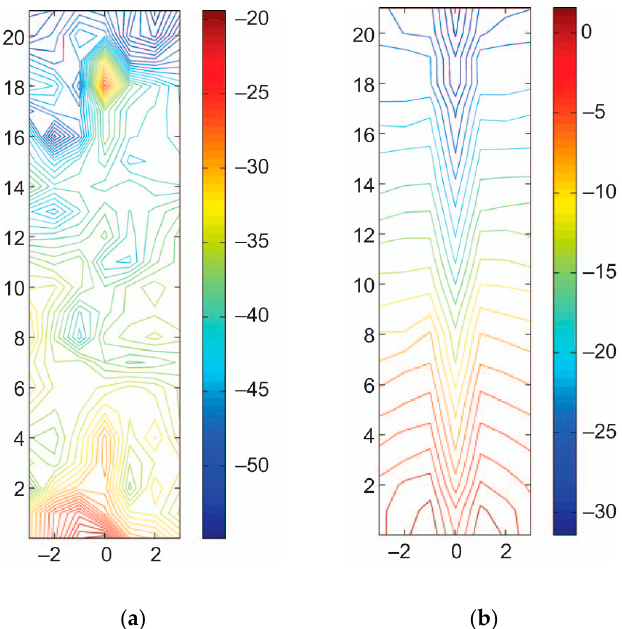
Figure 7. Contour plots of magnitude and phase of the frequency response at 62 Hz: ( a ) magnitude of velocity in dB relative to velocity measured by geophones adjacent to excitation point; ( b ) spatially unwrapped phase in radians. The axes correspond to the axes shown in Figure 6c, rotated by 90°; the pipe runs up the center-line in each plot [69], Copyright Elsevier, 2011.